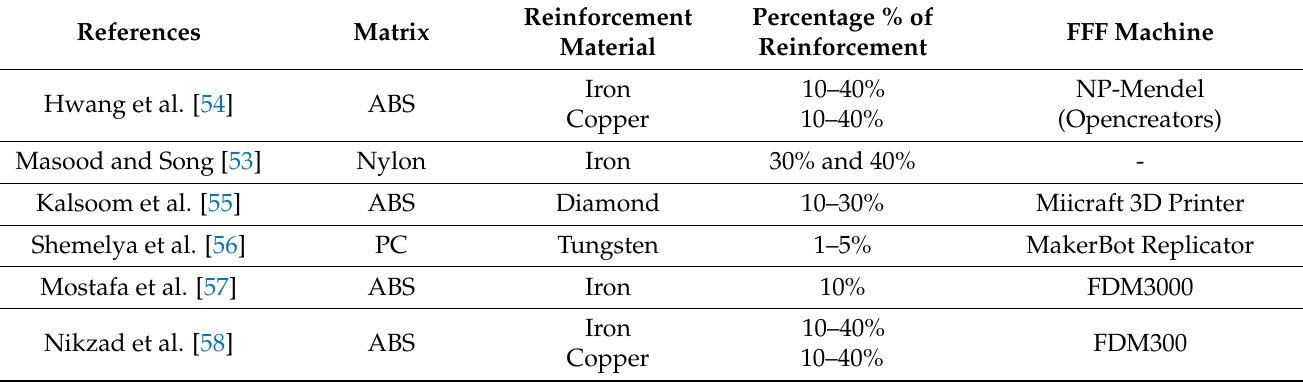
Table 4. Particulate Composites for filaments. ABS—acrylonitrile butadiene styrene, PLA—polylactic Acid, PC—polycarbonate, PA—polyamide, PA12—polyamide 12, polyvinyl alcohol, ZrO 2 —zirconium di-oxide, Al 2 O 3 —aluminum oxide,